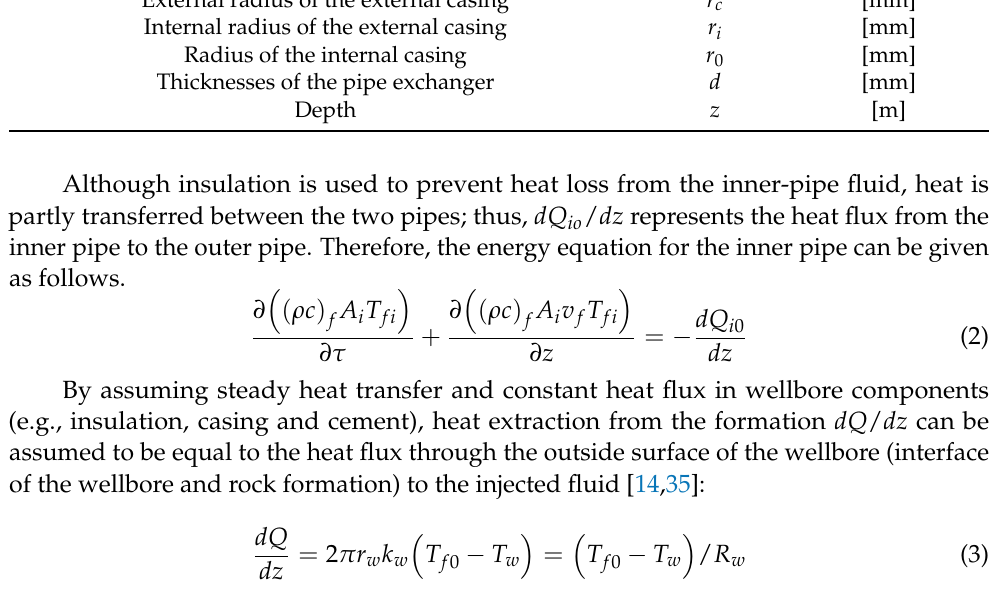
Table 2. Coaxial WBHE–geometric parameters. Coaxial Wellbore Heat Exchanger-Geometric Parameters Symbol Unit of Measure Outer pipe area A 0 [m 2 ] Inner pipe area A i [m 2 ] Radius of outside wellbore r w External radius of the external casing r c Internal radius of the external casing Radius of the internal casing Thicknesses of the pipe